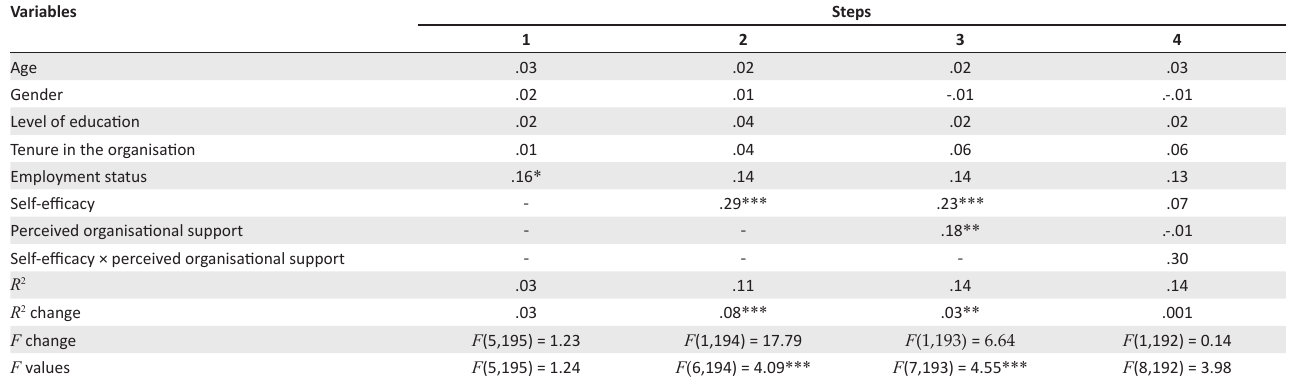
TABLE 2: Hierarchical regression